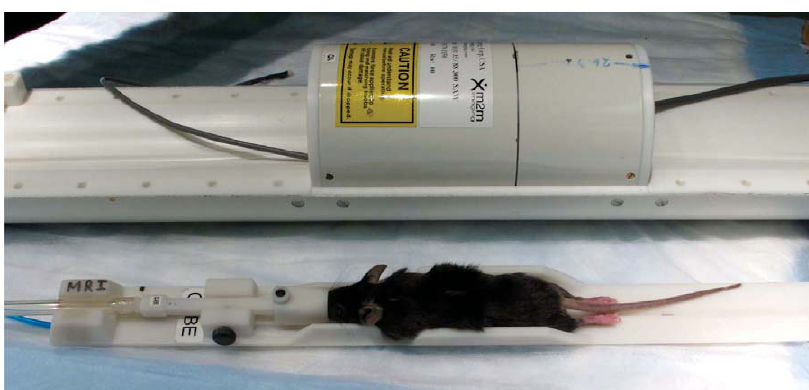
Fig.6. Adedicatedcradlehelpstoquicklyandaccuratelyrepositionamousewithintheradiofrequencycoil(topfigure),whileallowinganesthesia to be administered by a nose cone, and to monitor physiologic parameters via a respiratory pillow, temperature probe and/or electrodes. (Colours are visible in the online version of the article;